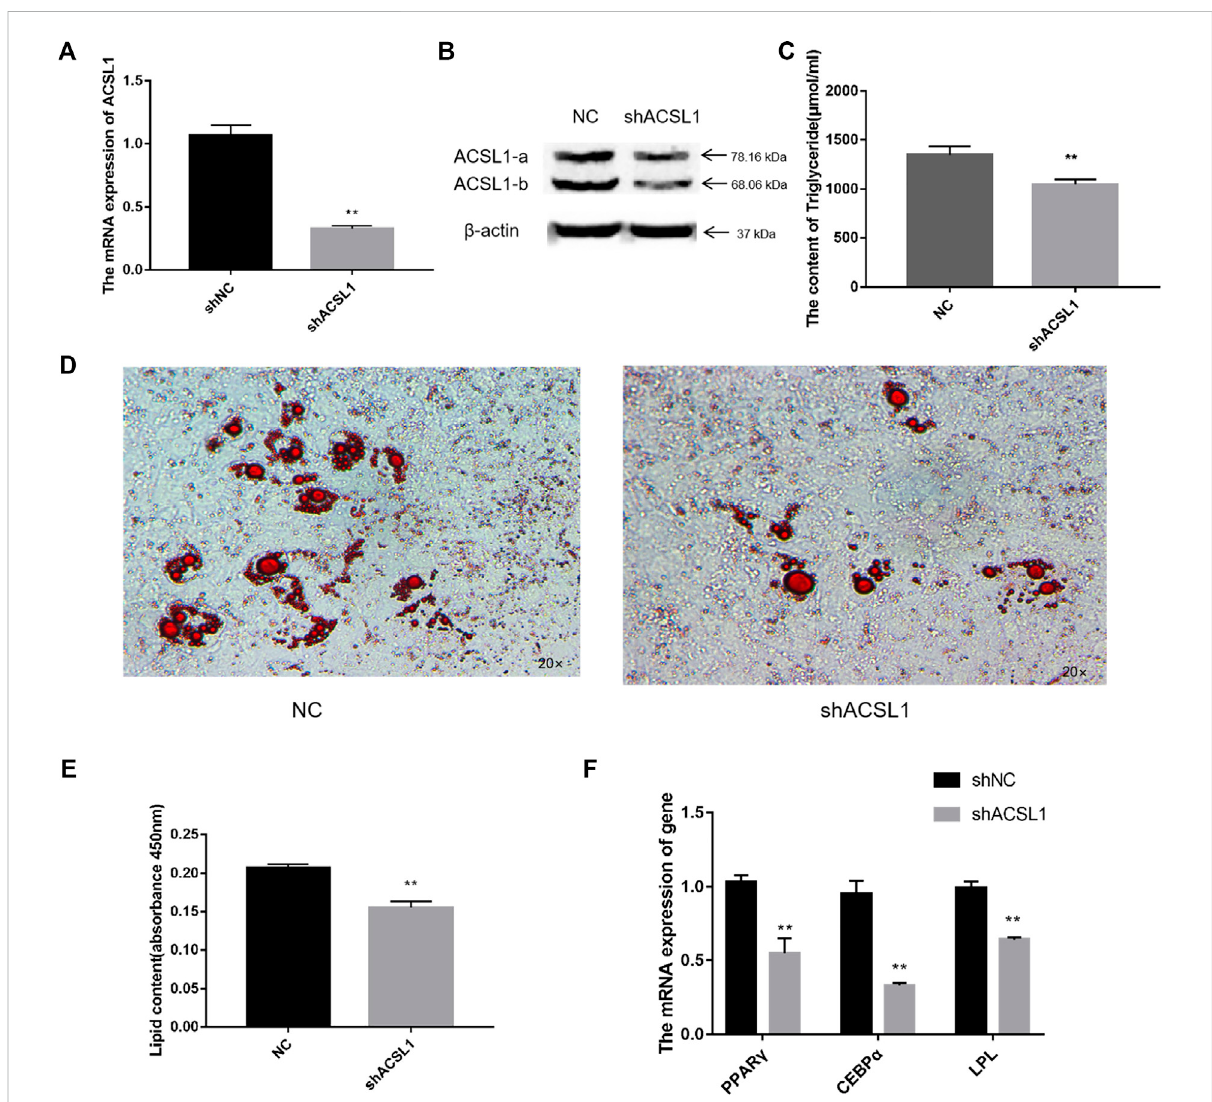
FIGURE 5 Knocked down of the ACSL1 gene in sheep preadipocytes: (A) mRNA expression of the ACSL1 gene on day 8 of differentiation (* p < 0.05, ** p < 0.01). (B) Protein expression of the ACSL1 gene on day 8 of differentiation. (C) Detection of intracellular triglyceride content. (D) Oil Red staining of adipocytes after induced differentiation on day 8 (left: control; right: knocked down ACSL1). (E) Absorbance value of Oil Red O after extraction. (F) mRNA expression of PPAR γ , CEBP α , and LPL in sheep adipocytes. NC: adipocytes transfected with shNC for control. ShACSL1: adipocytes transfected shRNA-297 of ACSL1